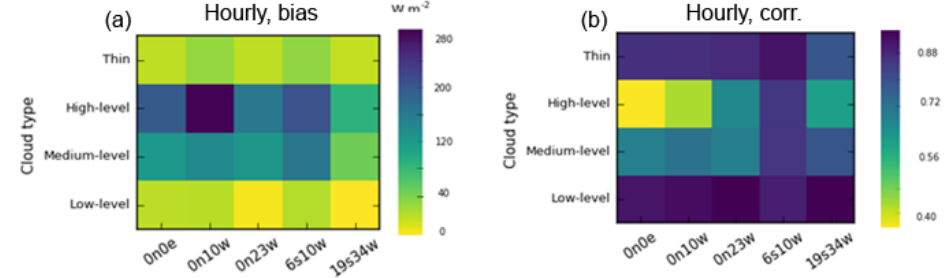
Figure 10. Bias ( a , in Wm − 2 ) and correlation coefficient (b) as a function of the cloud type at each PIRATA buoy for